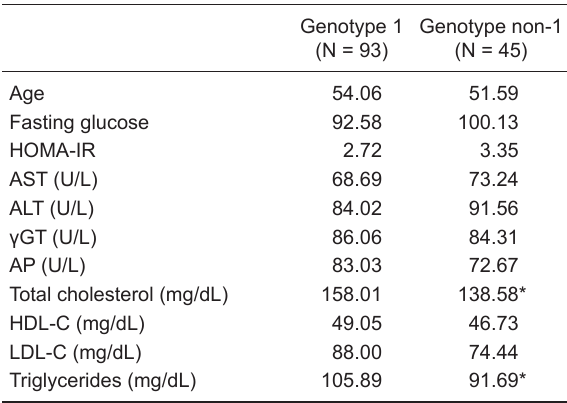
Table 1. Clinical and biochemical characteristics of chronic hepa- titis C patients according to genotype classification.